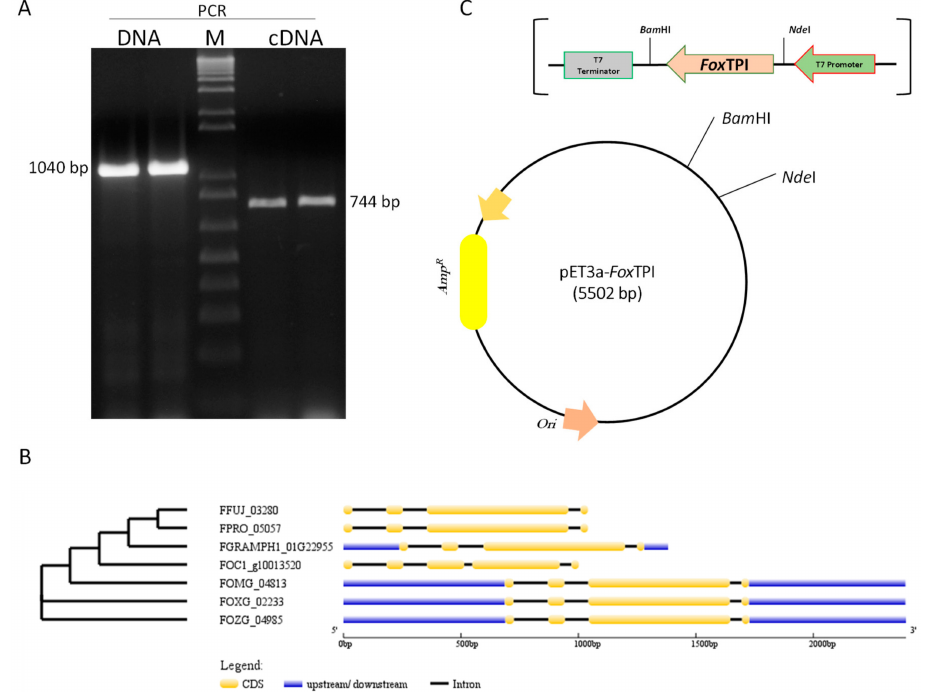
Figure 1. Isolation, analysis, and cloning of the FoxTpi gene. ( A ) amplification of the gene from DNA and cDNA by PCR and RT-PCR, respectively, using degenerate primers. (M) An amount of 1 kb